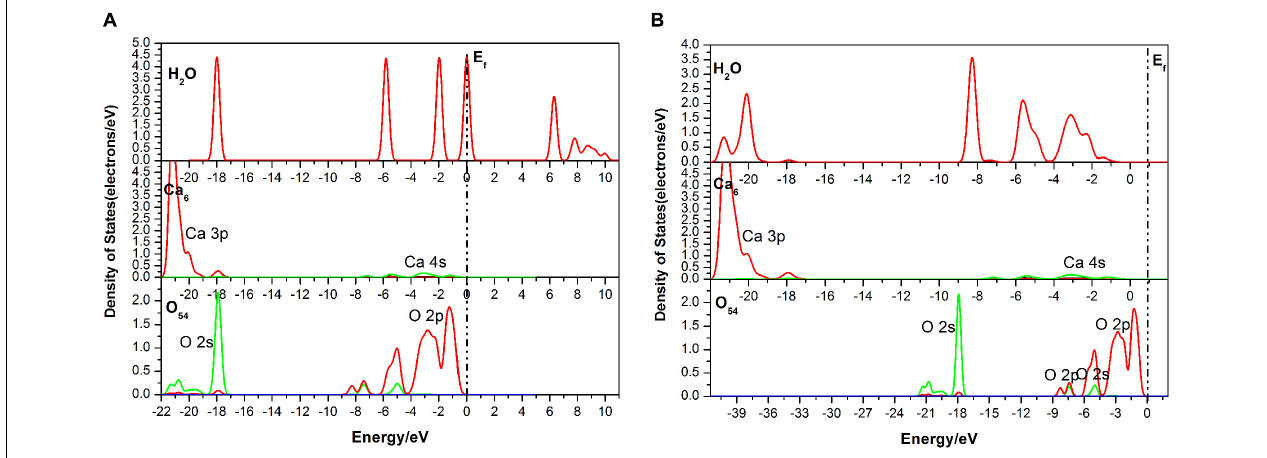
FIGURE 6 | Densities of states (DOS) of the corresponding atoms of the double-site adsorption: (A) before adsorption; (B) after adsorption.